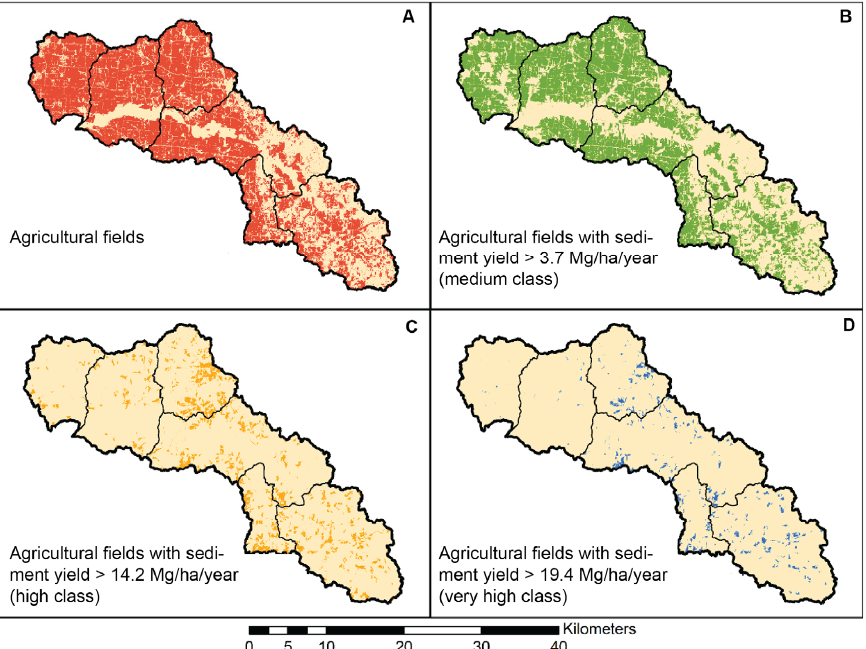
Figure 5. Study area agricultural fields classified by sediment yield (( A ): All agricultural fields, ( B ): medium class, ( C ): high class, and ( D ): very high class). These four classes are used as scenarios